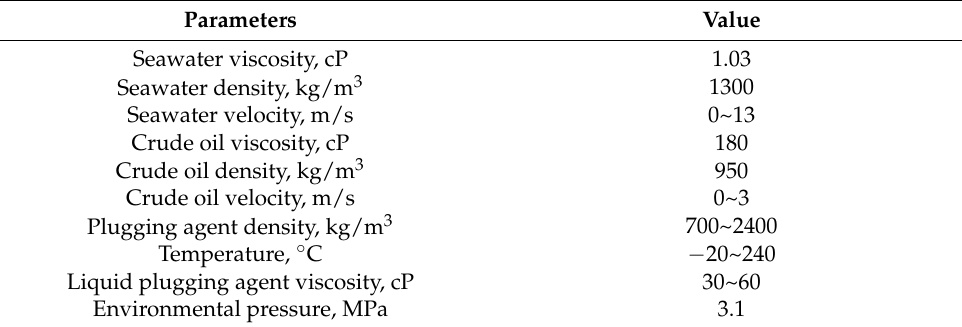
Table 3. Simulation parameters of the turbulence